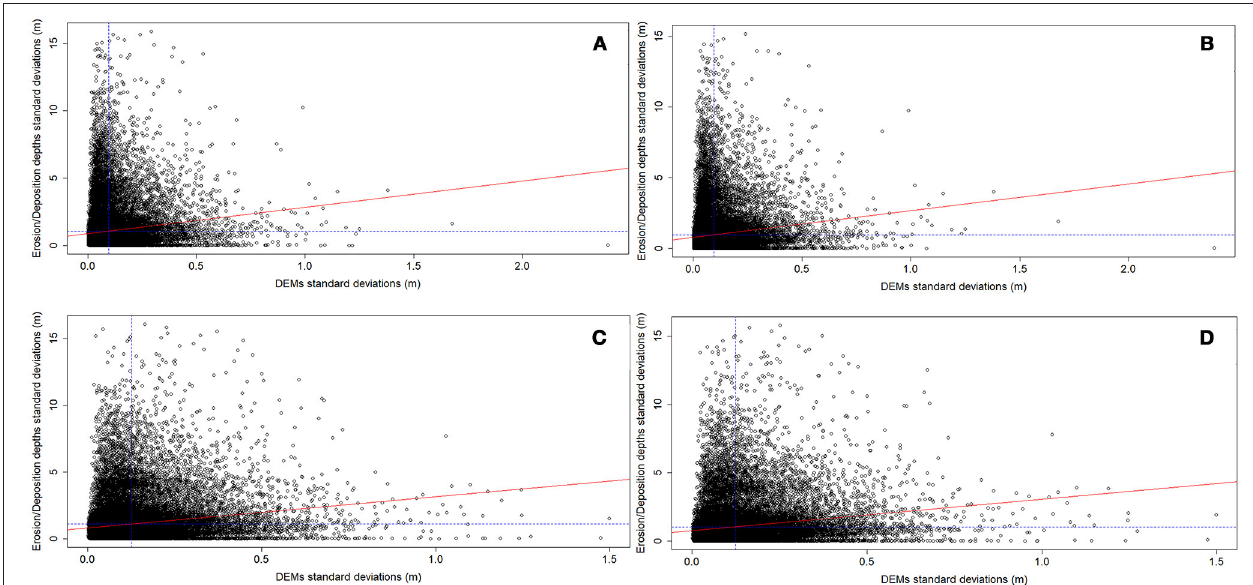
FIGURE 9 | Scatterplot of the pixel-wise standard deviations of the twelve 1-meter resolution DEMs heights and the pixel-wise standard deviation of the corresponding twelve simulated erosion/deposition depths: (A) full dataset-derived DEMs and 300-years return period (rho Pearson 0.126, rho Spearman 0.205), = = (B) full dataset-derived DEMs and 50-years return period (rho Pearson 0.129, rho Spearman 0.208), (C) 50% thinning-derived DEMs and 300-years return period = = (rho Pearson 0.167, rho Spearman 0.252), and (D) 50% thinning-derived DEMs and 50-years return period (rho Pearson 0.172, rho Spearman 0.256). The = = = = continuous red line corresponds to the linear regression line, whereas the dotted blue lines correspond to the marginal mean of the two correlated